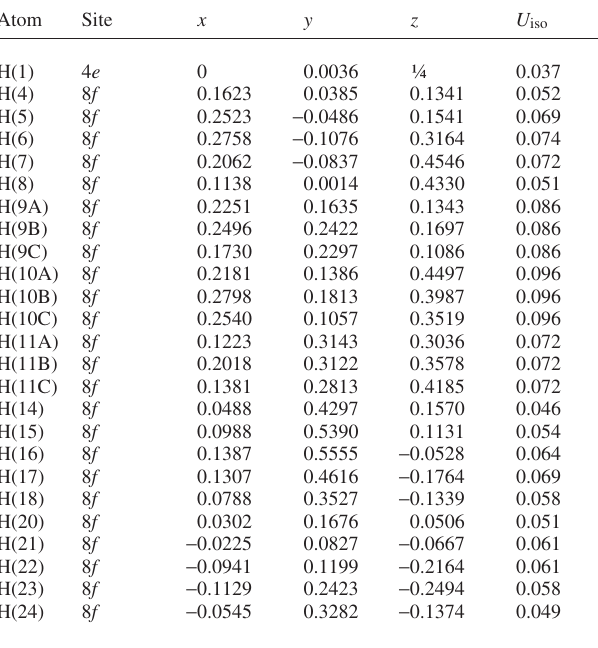
Table 2. Atomic coordinates and displacement parameters (in Å 2 )